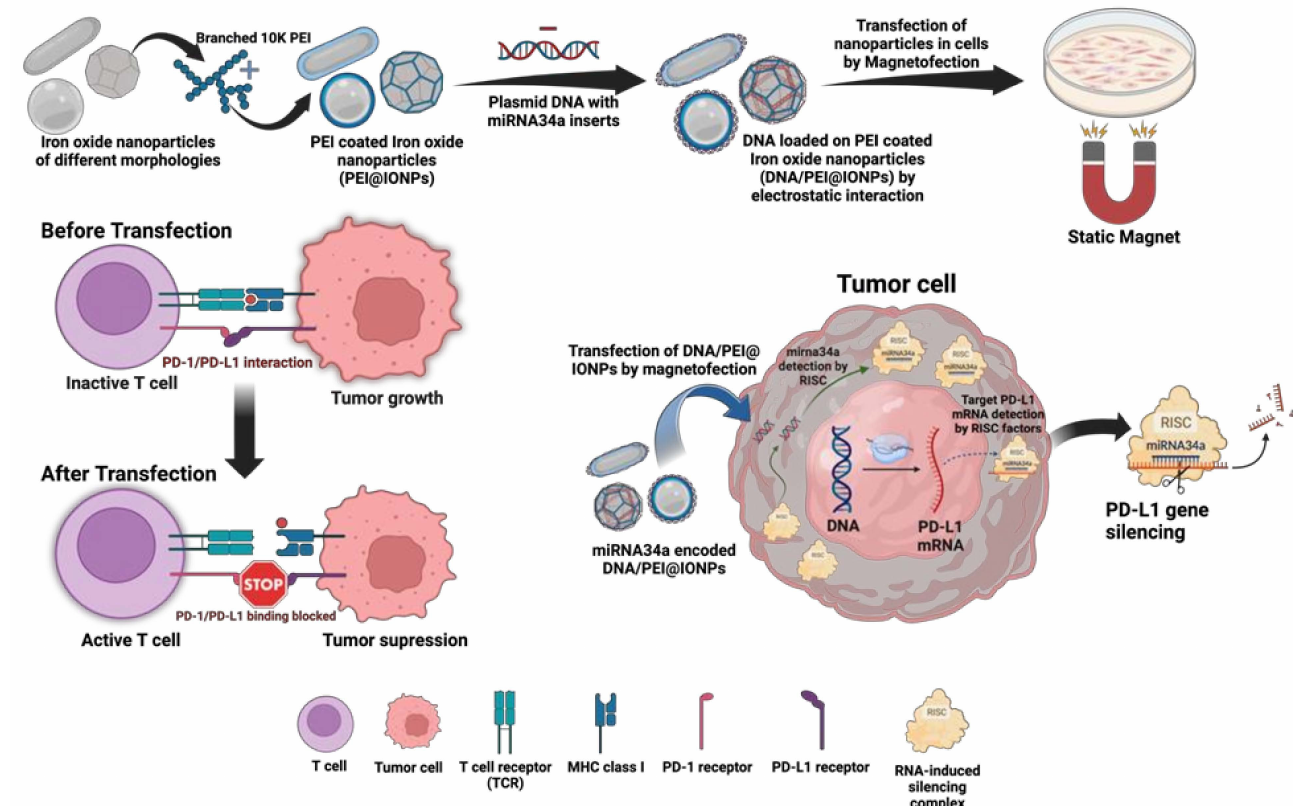
Scheme 1. Illustration of the synthesis of iron oxide nanoparticles (IONPs) with three different morphologies, and surface functionalization with positively charged branched polyethylenimine (B-PEI). Plasmid DNA (pDNA) with miRNA34a inserts is encapsulated on the surface of B-PEI-coated IONPs (PEI@IONPs) with electrostatic interactions as DNA is negatively charged. The PEI@IONPs and pDNA magnetoplexes are transfected into cancer cells using a static external magnet to study gene delivery efficiency. Upon PD-L1 interaction with the programmed cell death protein 1 (PD-1) on T cell surfaces, the T cells become inactive and unable to help the immune system to fight against tumor growth. The PD-L1 present on the tumor cell surfaces is targeted by miRNA34a-encoded pDNA using PEI@IONPs. pDNA internalization and release inside the cell happen mostly via the enhanced permeability and retention (EPR)/proton sponge effects, and the desired PD-L1 gene silencing takes place gradually due to various factors inside the